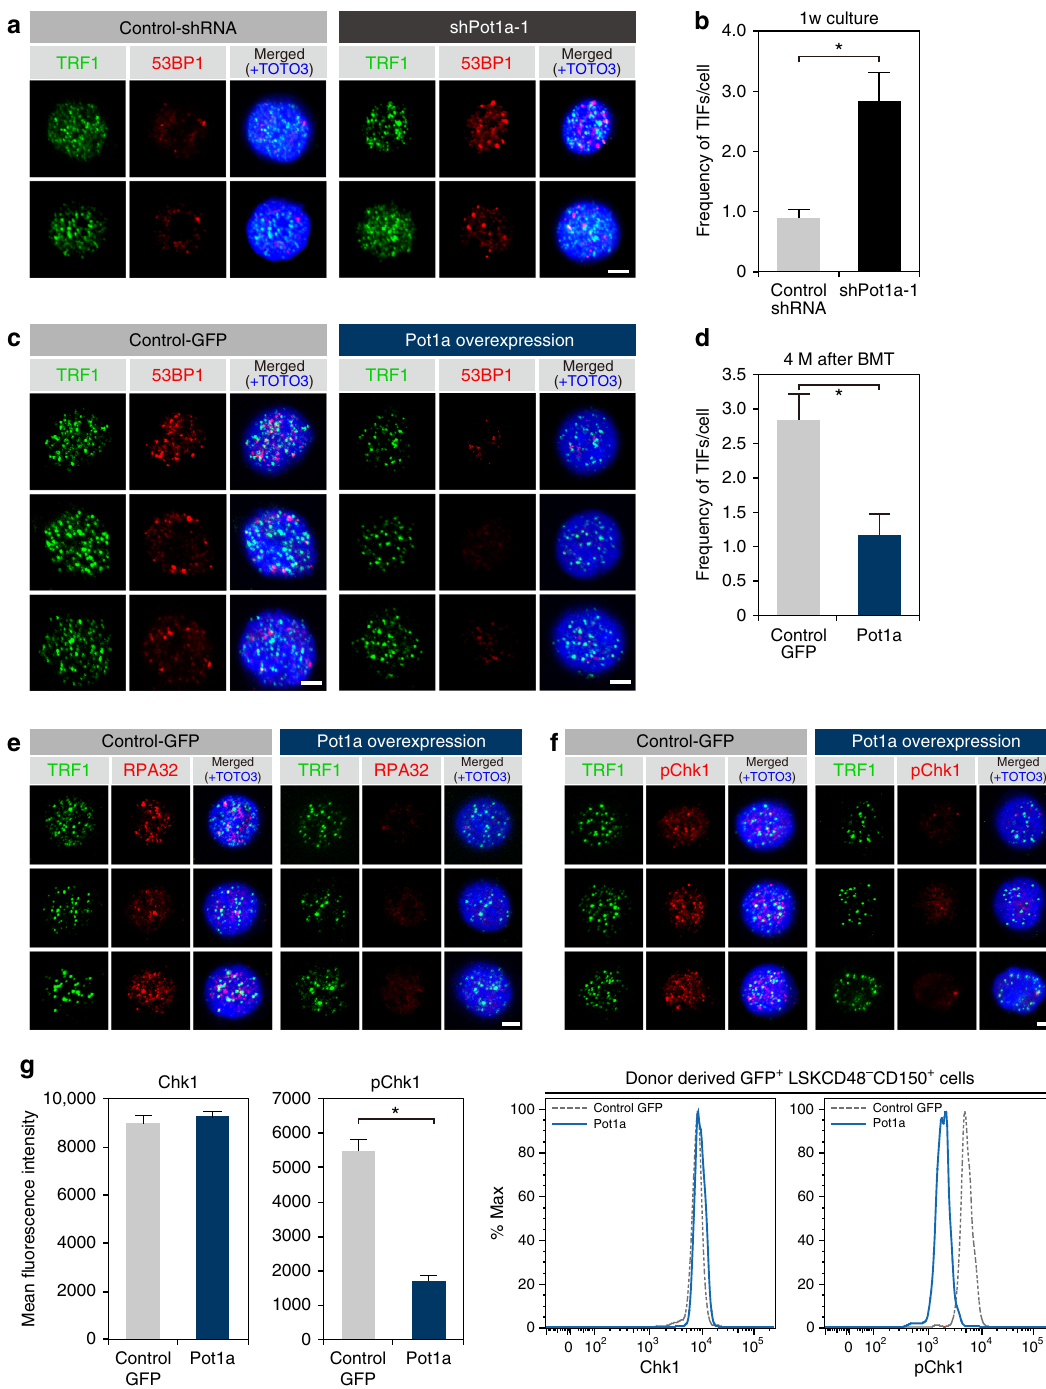
Fig. 4 Pot1a prevents DDR in HSCs. a , b Telomeric DDR in 8 week-old LSK cells upon Pot1a knockdown. a Immunocytochemical staining of TRF1 ( green ) and 53BP1 ( red ). Foci co-stained with TRF1 and 53BP1 were identi fi ed as TIFs. Nuclei were stained with TOTO3 ( blue ). Scale bar , 2 μ m. b Frequency of TIFs per cell after 1 week of culture. Data are expressed as the mean ± SD ( n = 100, * p < 0.01 by t -test). Representative data from three independent experiments are shown. c – f Telomeric DDR in donor-derived control-GFP or Pot1a overexpressing 8 week-old LSK cells 4 months post BMT. c Immunocytochemical staining of TRF1 ( green ) and 53BP1 ( red ). Nuclei were stained with TOTO3 ( blue ). Scale bar , 2 μ m. d Frequency of TIFs per cell. Data are expressed as the mean ± SD ( n = 120, * p < 0.01 by t -test). Representative data from 3 independent experiments are shown. e Immunocytochemical staining of TRF1 ( green ) and RPA32 ( red ). f Immunocytochemical staining of TRF1 ( green ) and pChk1 ( red ). Scale bar , 2 μ m. g Flow cytometric analysis of Chk1 and pChk1 in donor-derived GFP + LSKCD48 – CD150 + cells after 5 months of 2nd BMT. Mean fl uorescence intensity of Chk1 and pChk1 ( left panels ). Data are expressed as the mean ± SD ( n = 3, * p < 0.01 by t -test). Representative FACS pro fi les of Chk1 and pChk1 in donor-derived GFP + LSKCD48 – CD150 + cells ( right panels